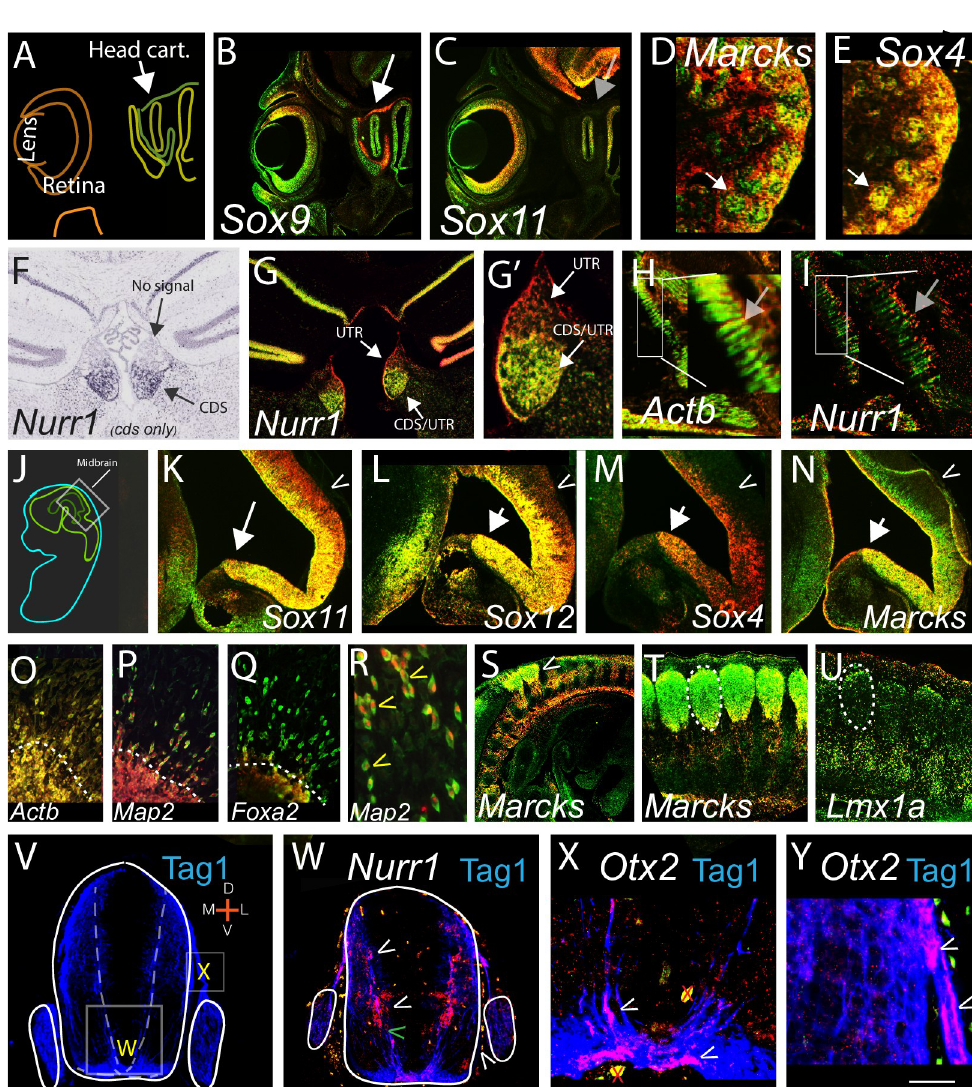
Fig 1. Widespread, specific, differential 3’UTR (red)/cognate CDS (green) expression across mouse tissues and ages. (A) Schematic of sagittal E15 eye and head cartilage region. (B,C) similar sections to A; probes for Sox9 and Sox11 detect unique signals (white arrow, signal, gray; no signal) ( unless specified, in all Fig 3‘UTR probe is red and CDS probe is green with both probes co-hybridized to same section ). (D, E and S1I, S1J Fig in S1 File) Kidney; Marcks shows high CDS in glomeruli, while Sox4 shows equal 3’UTR/CDS in same region in adjacent section; white arrows. (F,G,G’); Nurr1 in adult brain hybridized with Allen brain atlas single CDS probe (F) (https://developingmouse.brain-map.org/ experiment/show/732) or in-house probes (G,G’). (G’) high power view of medial habenula showing high Nurr1 3’UTR throughout, CDS restricted ventrally. (I) Nurr1 in E15 muscle shows distinctly high 3’UTR at muscle fiber tips while Actb (H ) shows CDS with some 3’UTR throughout; (H,I; gray arrows; insets). (J) Schematic, sagittal E15 embryo. (K-N) Similar adjacent sections as J inset, showing SoxC family members and Marcks . Arrows show newly developing neurons, carrots show dorsal brain (additional genes in S1L, S1M Fig in S1 File). (O-Q) Actb , Map2 , Foxa2 3’UTR/CDS in E15 neural explants in vitro; dotted line shows explant edge, cells above that are migrating on substrate. (R) High power showing Map2 3’UTR confined to the nucleus with the CDS in the cytoplasm in migrating cells. Actb also shows high 3’UTR nuclear signal in migrating neurons, while Foxa2 (Q) does not. (n = 16 explants/probe; all probes showed replicate patterns). (S-Y) 3’UTR/CDS expression in and around developing axons; (S,T) In sagittal view Marcks shows high CDS in DRG cell bodies (dotted circle T) but high 3’UTR in axons (carrot; S). (U) Lmx1a in adjacent section shows no obvious axonal expression. (V-Y), E11 spinal cord-early developmental genes show high 3’UTR in or alongside Tag1+ axons (V). (W) Nurr1 3’UTR is highly expressed along axon path; carrots. (X,Y) Otx2 in the axons; carrots. Both Otx2 and Nurr1 show robust CDS signal in other sections (G, and S1O Fig in S1 File or not shown). Scale bar, A-C; 600, D,E; 300 F,G; 450, G’ 200, H,I; 1200; inset 300 J; 1600 K-N; 300, O-Q 800, R; 300, S; 1500, T,U; 500, V,W; 220, X, 100, Y, 80 um. Red x’s in X are